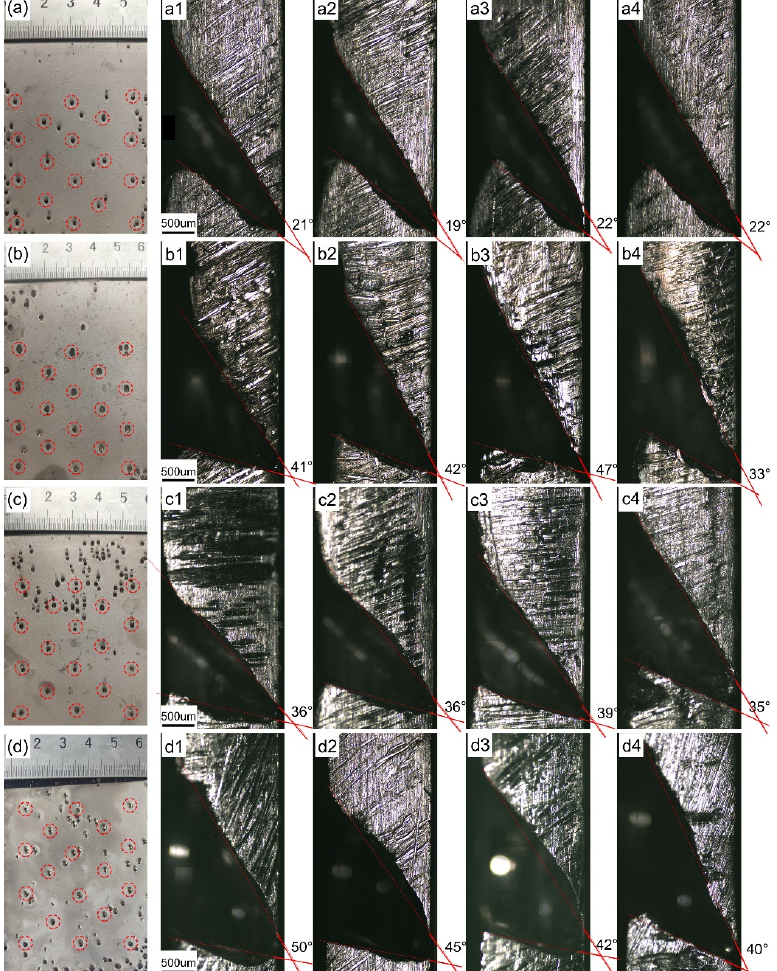
Figure 5. The morphology of depositions at different stirring speeds: ( a ) 240 r/min; ( b ) 320 r/min; ( c ) 400 r/min; and ( d ) 480 r/min. ( a – d ) and ( a1 – d4 ) are the front and cross-sectional morphology of the macropore, respectively. Table 2. Angles of bell-mouthed macropores’ outline in depositions at different stirring speeds. Stirring speed